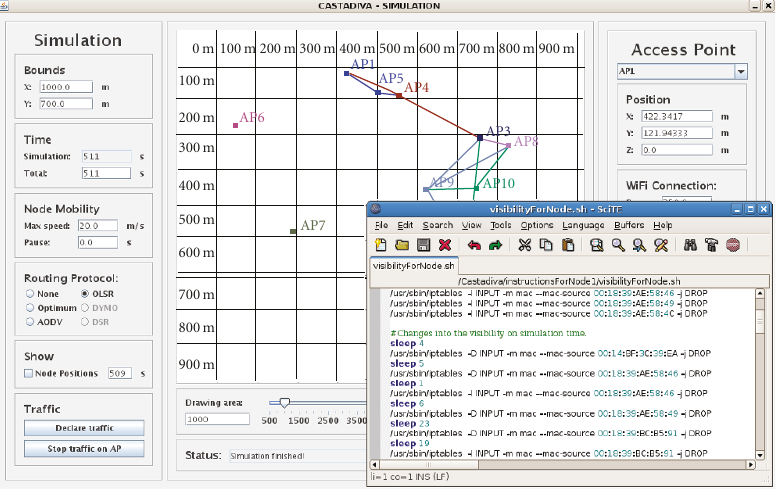
Figure 7: Mobility implementation.